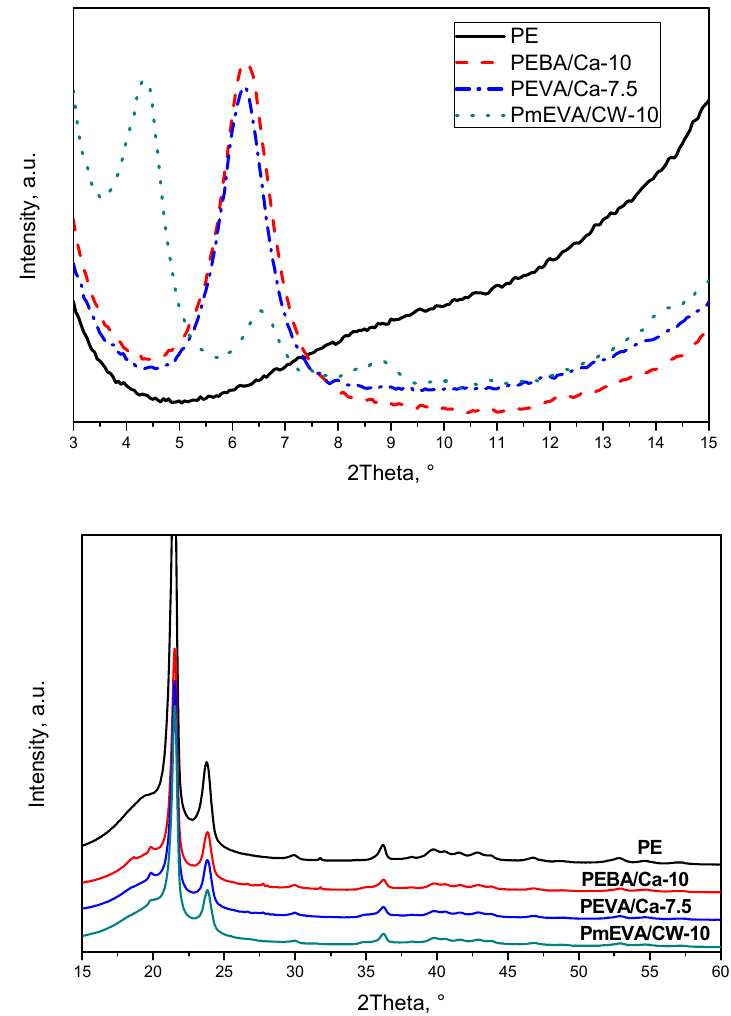
Figure 5. XRD patterns for selected MMT-based PE composites.